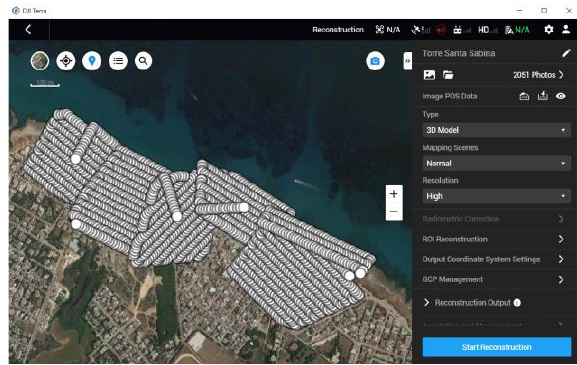
Figure 4. Screenshot of the DJI Terra software with the acquired UAS data using the Phantom 4 RTK.